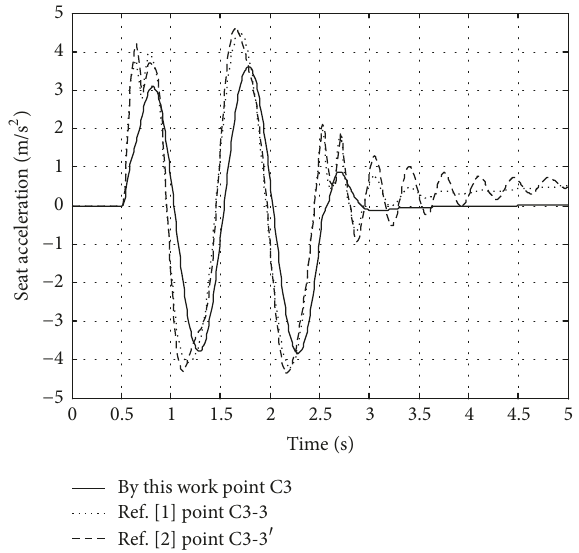
Figure 17: Time response of seat acceleration of design points C1, C1 1, and C1 1 󸀠 .